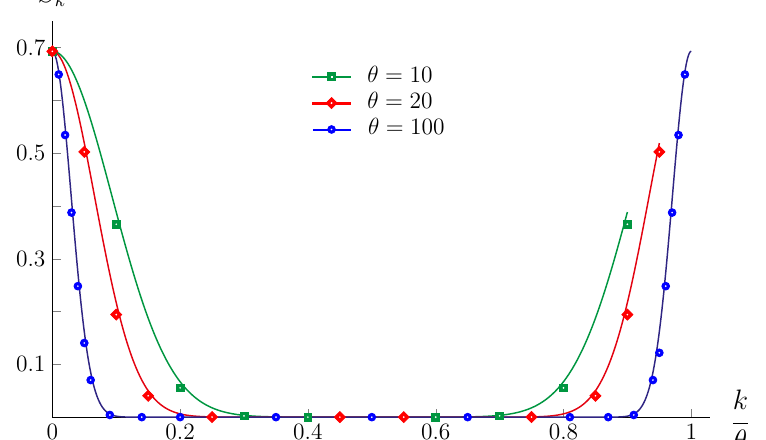
Figure 3. Entanglement entropy as a function of the ratio k=(cid:18) for several (cid:12)xed values of (cid:18) and varying k . The solid lines represent the analytical approximation obtained in eq. (3.5). The dots have been obtained numerically from the matrix (3.6), taking as cut-o(cid:11) N = 100.